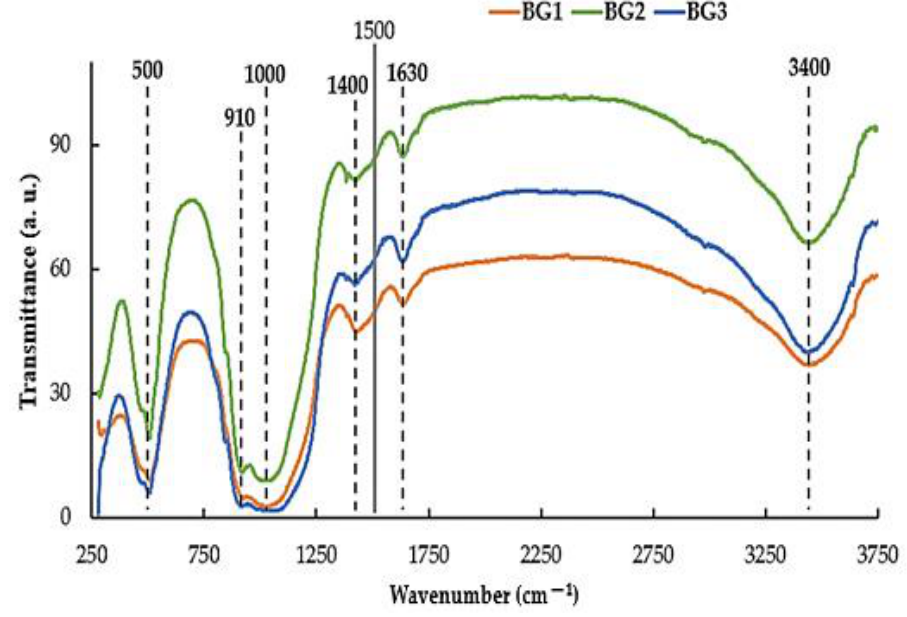
Figure 3. FTIR spectra of samples BG1, BG2, and BG3, after calcination at 700 °C.